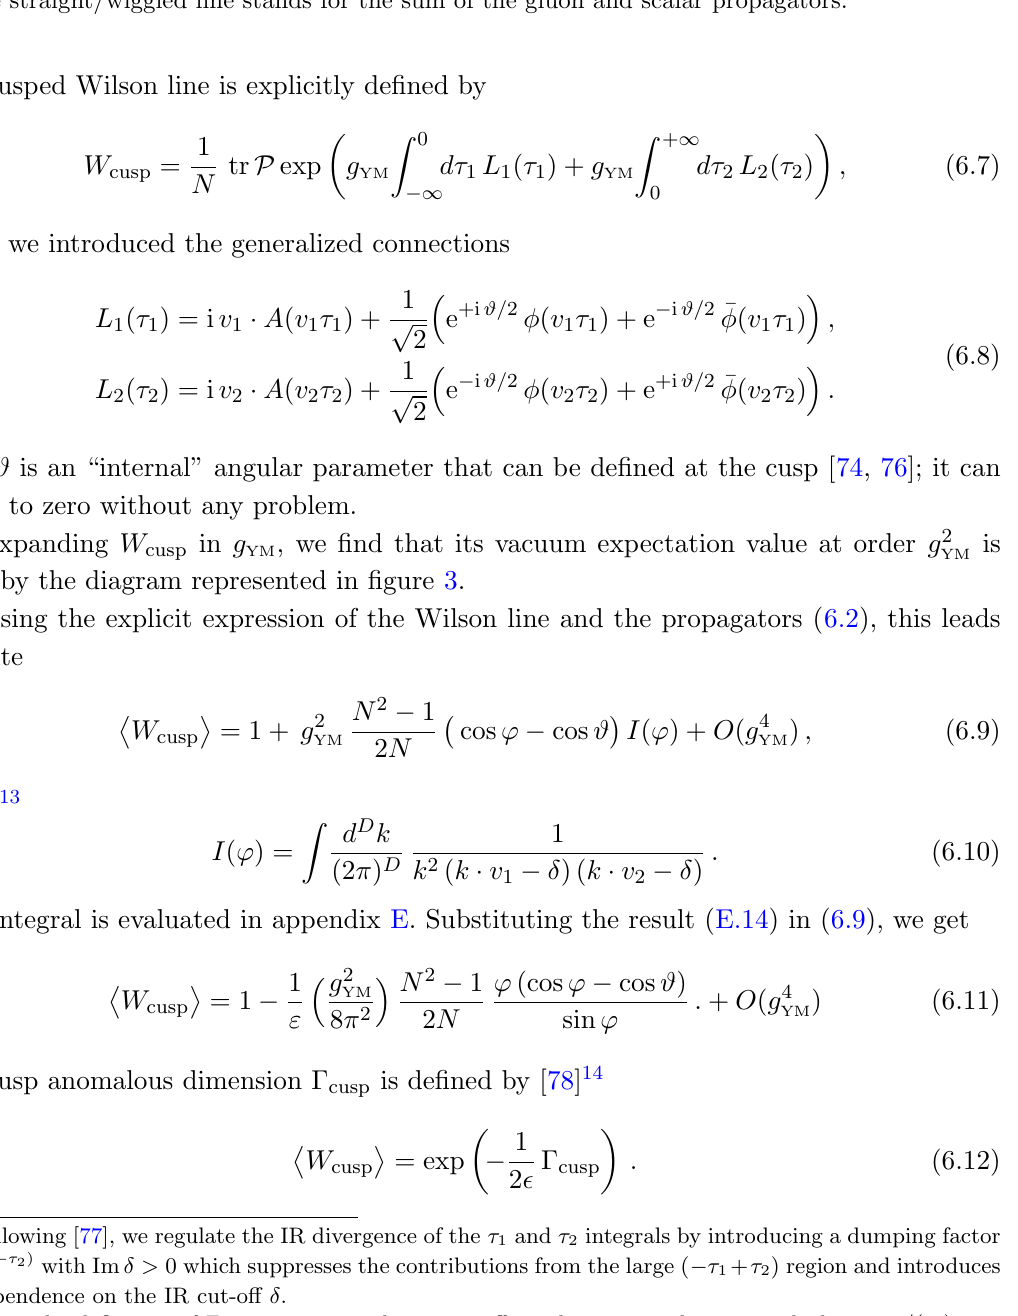
Figure 3 . The g 2 -contribution to the vacuum expectation value of a cusped Wilson line. The YM double straight/wiggled line stands for the sum of the gluon and scalar